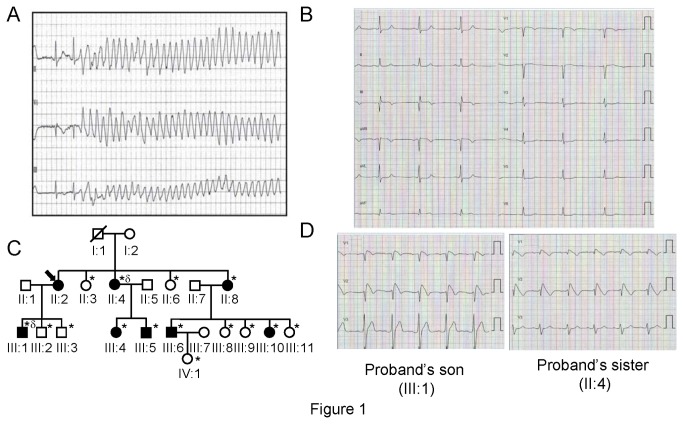
Clinical characterization and pedigree of the proband.
A. ECG of the proband at hospital admission with an episode of ventricular fibrillation initiated by a premature ventricular contraction (paper speed 25 mm/s). Reprinted from [21] under a CC BY license, with permission from Elsevier original copyright (2011). B. 12-Lead ECG of the proband after flecainide continuous infusion at 2 mg/kg for 10 min (paper speed 25 mm/s). C. Pedigree of the affected family. Circles and squares represent female and male subjects, respectively. White and black symbols represent unaffected and affected individuals, respectively. The arrow denotes the proband. Diagonal lines indicate deceased subjects. The asterisk denotes proband`s relatives subjected to genetic and electrophysiological analyses (including flecainide test). Patient named in the figure as III.4 was excluded from the pharmacological test and ECG analysis because she had suffered Tetrallogy of Fallot that had been corrected in childhood, although she is a mutation carrier. δ denotes proband`s relatives who displayed type 1 BrS pattern after flecainide challenge. D. ECG of the proband´s son (top) and sister (bottom) after flecainide challenge.